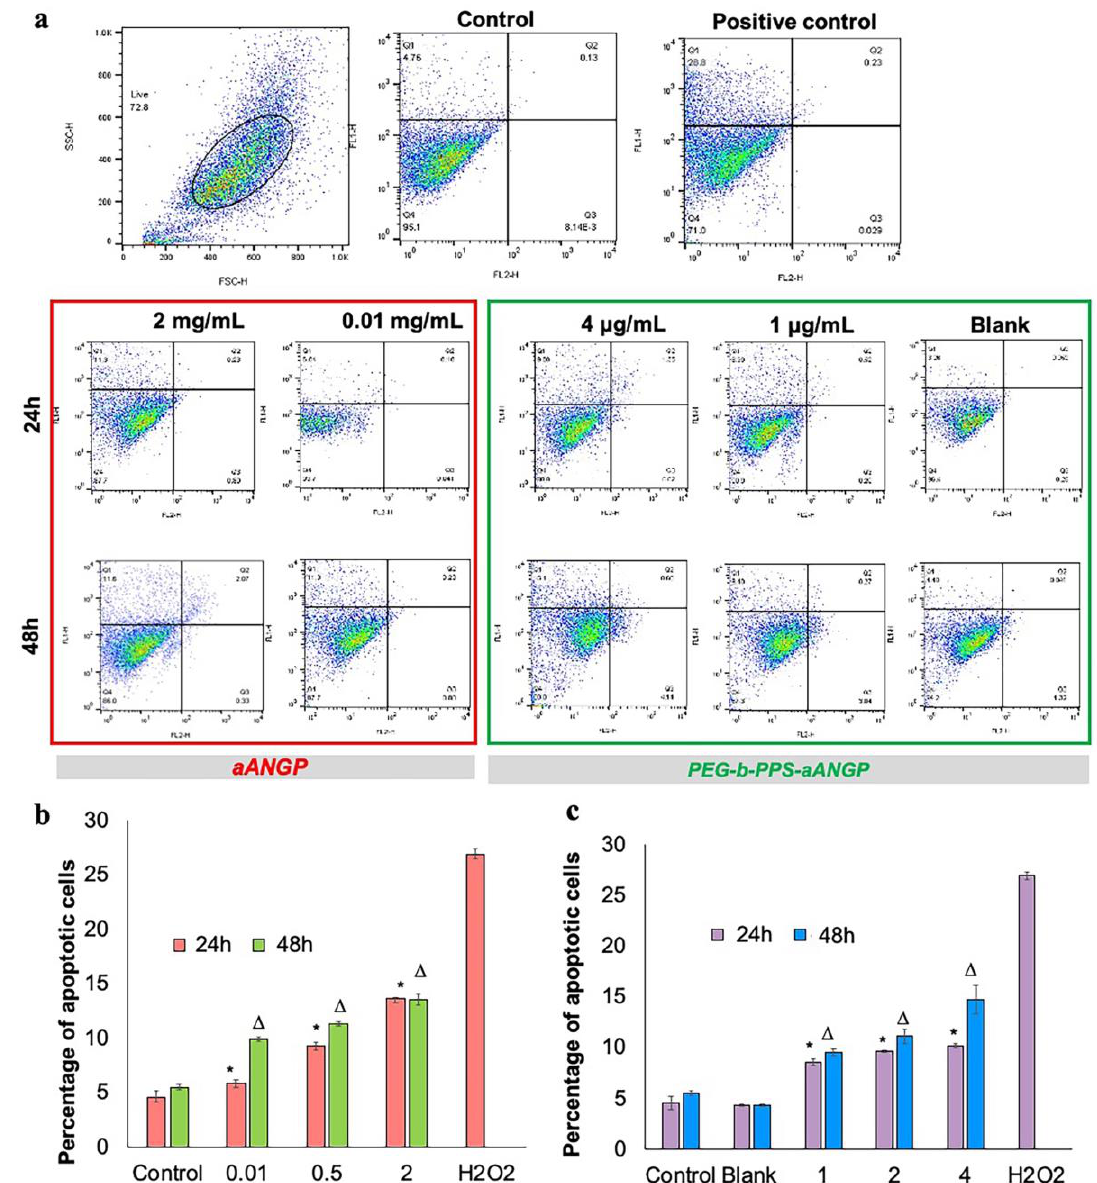
Figure 7. Apoptosis induced by aANGP and aANGP-MCs: HUVECs were treated with di ff erent concentrations of aANGP and aANGP-MCs for 24 and 48 h followed by Annexin V-FITC and PI staining. ( a ) Dot plots obtained after analyzing aANGP treated HUVECs using Flow cytometry at 24 and 48 h. Bar graphs represent the quantification of the dot plots obtained for ( b ) aANGP and ( c ) aANGP-MCs treated HUVECs were stained with Annexin V-FITC and PI and imaged using a fluorescent microscope at 20 × magnification. Values were expressed as mean ± SD, n = 3. * (24h) and ∆ (48h) * p <